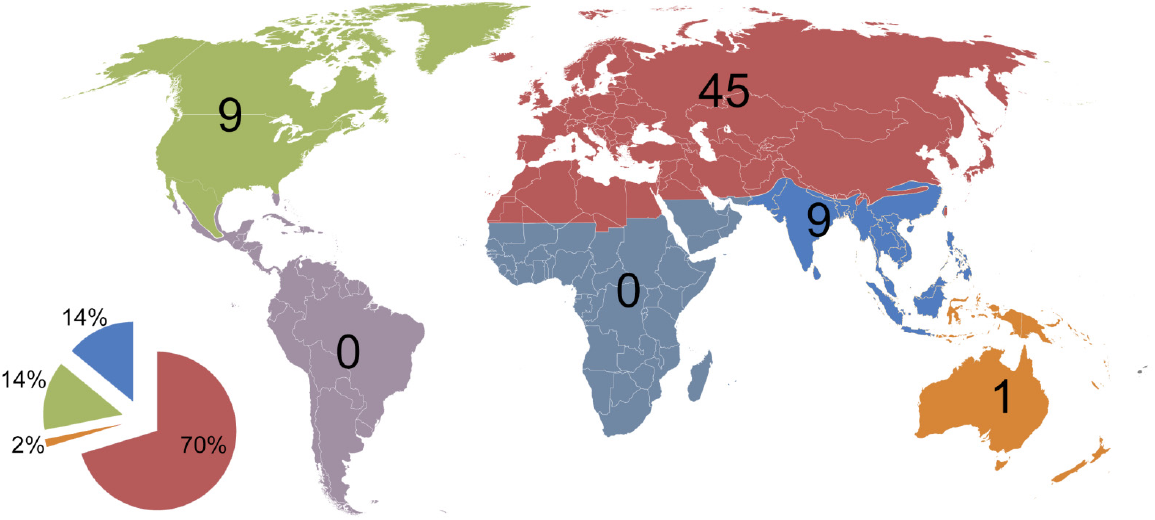
Figure 3. Number and percentage (pie chart) of Aphidiinae species described in different biogeo- graphic realms in 2010–2021.